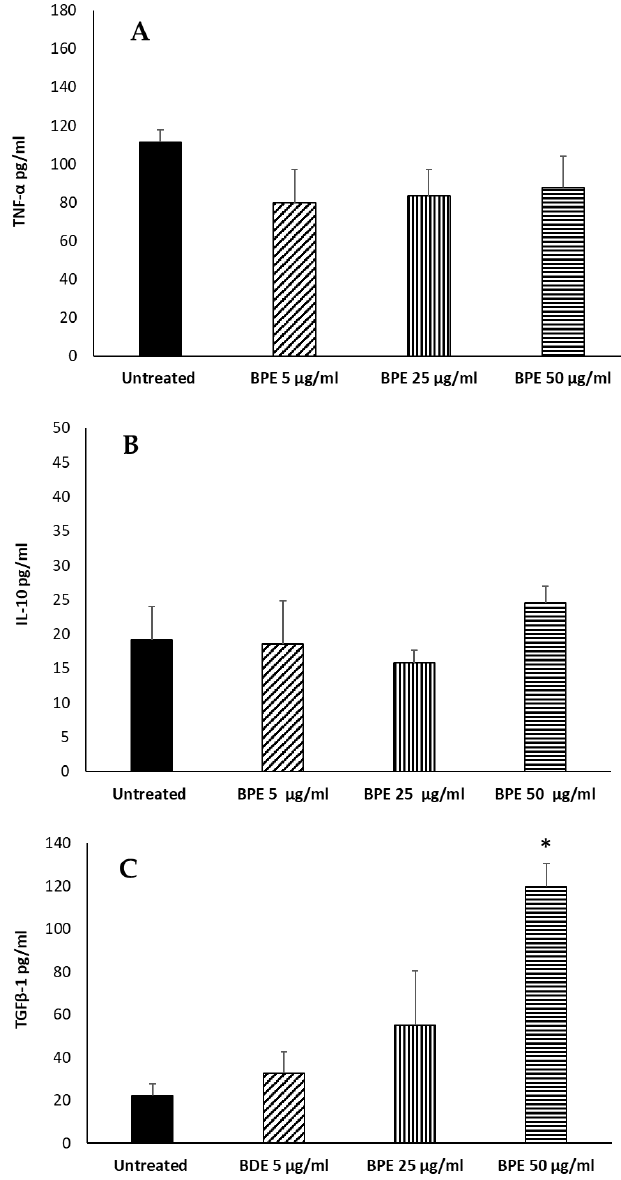
Figure 10. Effect of BPE on TNF- α ( A ), IL-10 ( B ), TGF β 1 ( C ) production by macrophages. THP-1- derived macrophages were stimulated with BPE. Data represent the mean ± standard deviation (SD) of three independent experiments. The statistical analysis was performed with a two-tailed Student’s t -test. * p < 0.05, (BPE-treated cells vs. untreated cells).